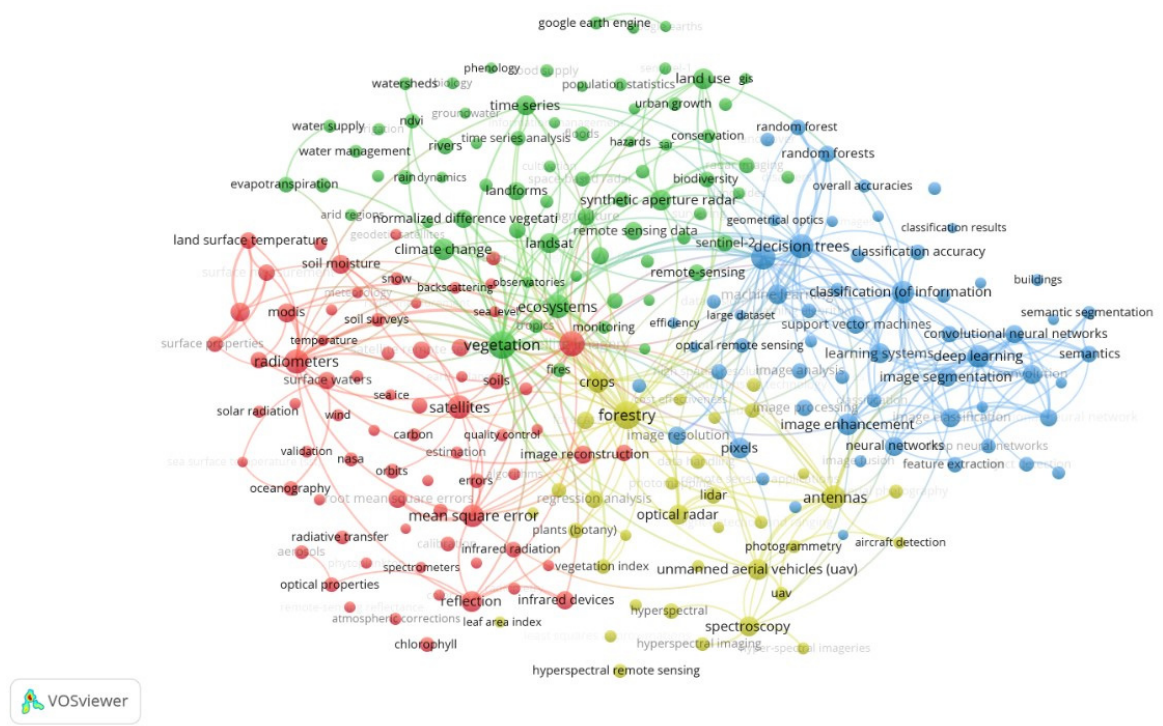
Figure 3 . VOSviewer output of keyword co-occurrences; journal Remote Sensing 2009–2021. See